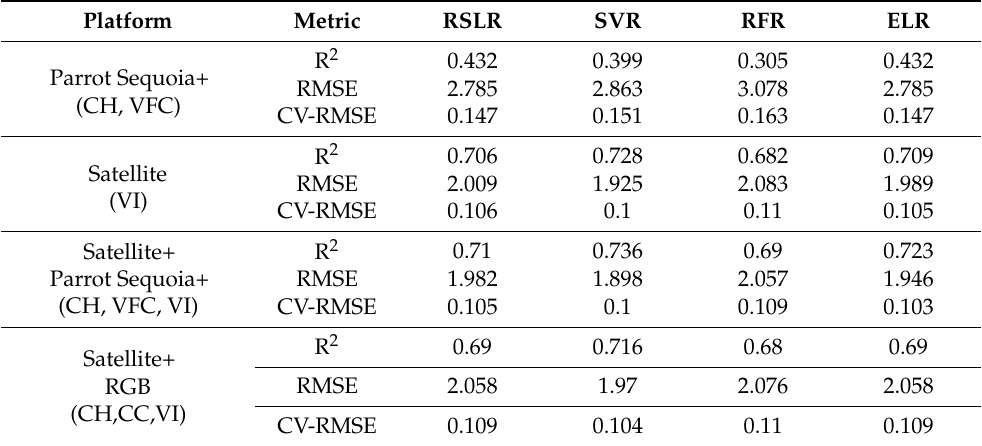
Table 4. Predictions of results from partial least squared regression (PLSR), support vector regres- sion (SVR), random forest regression (RFR), and extreme learning regression (ELR) based on dif- ferent features.